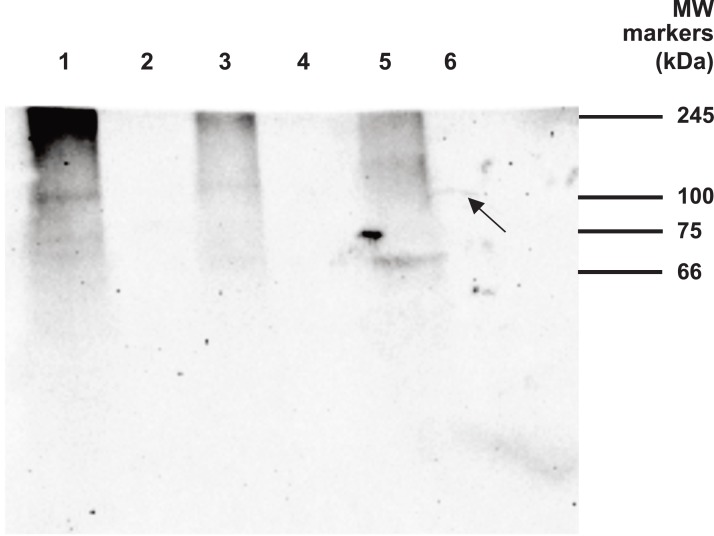
Western blot analysis of Drosophila embryo material.Samples were analysed by 12% SDS PAGE under non reducing conditions and then by western blot using the goat polyclonal antibody at a dilution of 1/400 and secondary antibody at 1/5,000. IP involved the same primary antibody. Lanes 1–6. Lane 1: Fruit fly material (unfixed) extracted with 1% NP40. Lane 2: IP of Lane 1 material. Lane 3: Fruit fly material (unfixed) extracted in RIPA buffer. Lane 4: IP of Lane 3 material. Lane 5: Fruit fly material (fixed) extracted in RIPA buffer. Lane 6: IP of Lane 5 material. Arrow denotes the only IP band, which is discernible in fixed material as faint and arched.